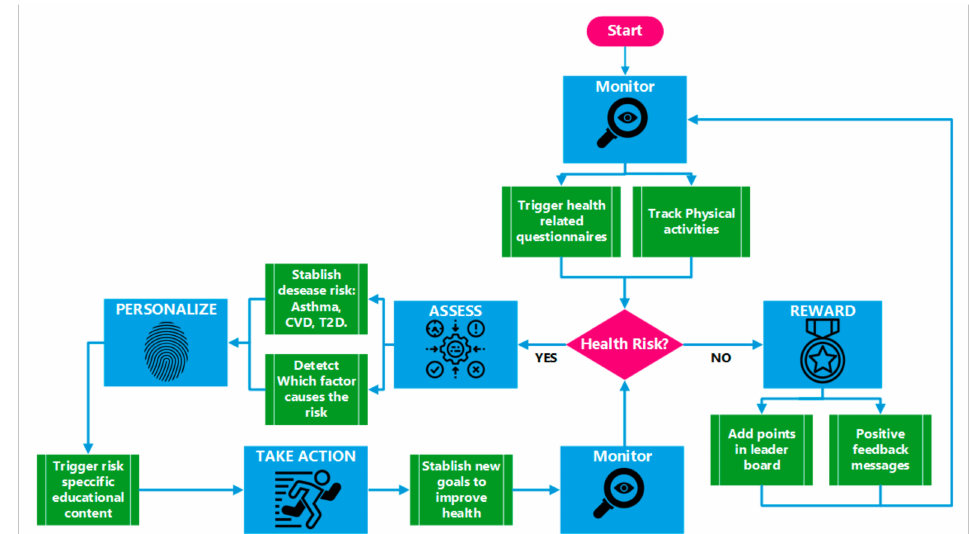
Figure 4. PulsAir mobile application workflow. CVD—cardiovascular disease.